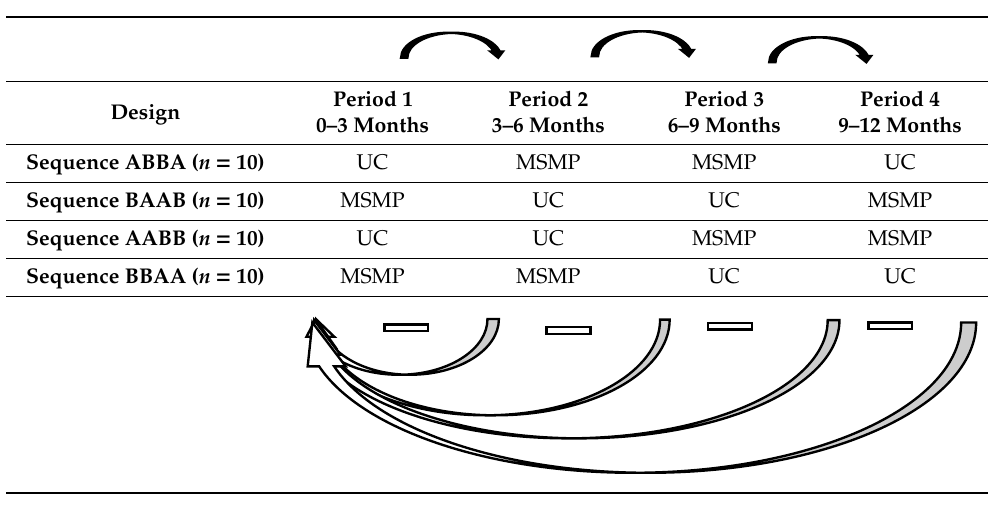
Table 1. Crossover plan of participants enrolled in the study.